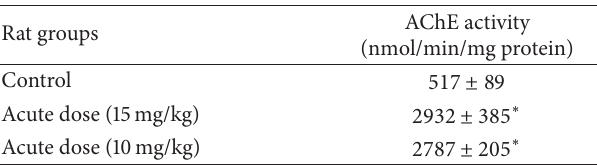
Table 1: AChE activity differences in presence of acute dose of Mn in short time (2 days). Asterisk symbols present significant changes ( 𝑃 < 0.01 ).